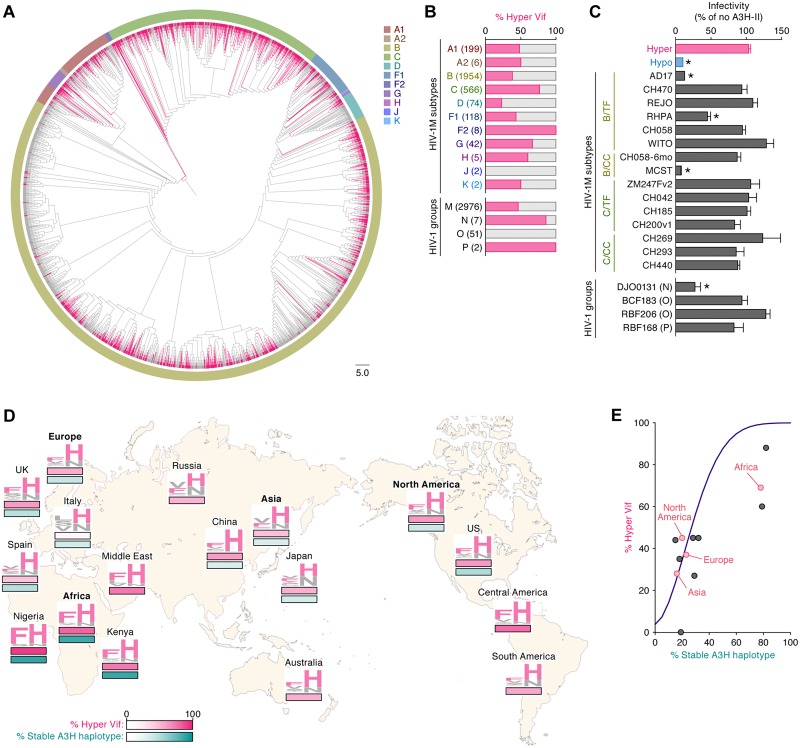
Dynamics of hyper/hypo HIV-1 dissemination in human population.(A) A phylogenetic tree of Vif. The Vif sequences were extracted from HIV-1 sequence database (https://www.hiv.lanl.gov/components/sequence/HIV/search/search.html) and the phylogenetic tree was constructed as described in Materials and Methods. The branches of hyper Vif sequences (i.e., F or Y in position 39 and H in position 48) are indicated with pink. Each color surrounding the phylogenetic tree represents viral subtype (A1-K). Scale bar indicates 5.0 amino acid substitutions per site. (B) The percentage of hyper Vif sequences in each subtype and group. The sequences of HIV-1 Vif is classified into hyper and hypo Vif based on the amino acids positioned at 39 and 48 and the result is summarized. The numbers in parentheses represents the number of Vif sequences used. See also S10 Table. (C) TZM-bl assay. The IMCs (1,000 ng) were cotransfected either with or without Flag-tagged A3H-II expression plasmid (50 ng) into HEK293T cells. The infectivity of released virus was determined by using TZM-bl cells, and the percentage of the value of "no A3H-II" is shown. *P < 0.05 versus "hyper HIV-1" by Student's t test. The assay was performed in triplicate. The data represents average with SD. TF, transmitted/founder; CC, chronic control. See also S9 Table. (D) Distribution of hyper HIV-1 and individuals with stable A3H in the world. The percentages of hyper HIV-1 (pink, top) and stable A3H haplotype (green, bottom) in each region (Europe, Africa, Asia and North America; represented in bold) and country were obtained as described in Materials and Methods, and these two values are indicated by heatmap. The Vif amino acids at positions 39 and 48 are shown in logoplot, and the residues associated with hyper Vif (i.e., F or Y in position 39 and H in position 48) are represented in pink. Note that the information of the proportion of A3H haplotype is not available in Russia, Australia, Central America and South America. See also S11 Table. (E) Mathematical modeling of the dissemination of hyper HIV-1 in human population. The prevalence of hyper HIV-1 in the human population with different stable A3H proportion was simulated by the mathematical model (for the detail, see Materials and methods). The simulated prediction is shown with purple line. Red and Black dots indicate the results from respective regions and countries (see also S9 Fig & S12 Table).